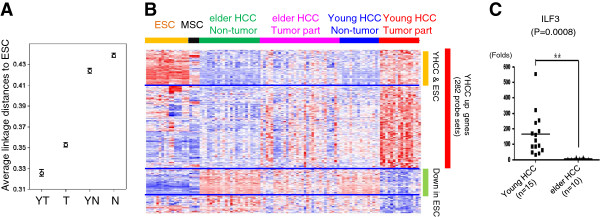
ESC traits in yHCCs. (A) Relationships between ESC, HCCs of different ages, and non-tumor tissues. Average linkage distances between tissues and ESC were calculated using the filtered 309 probe sets. The confidence limits as shown represent the standard error. YT and T: cancerous HCC samples from young and elderly patients, respectively. YN and N: non-tumor samples. (B) A heat map showing shared genes between yHCC and ESC. (C) Validation of ILF3 array data by real-time RT-PCR. The mean expression levels of the target genes were compared to the GAPDH control. **: p < 0.01 by t-test.